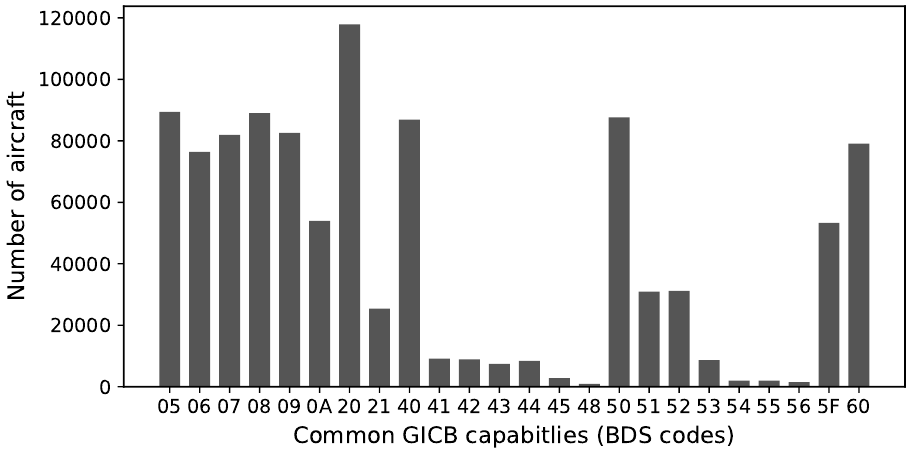
Figure 2. Available GICB capability statistics among all aircraft with valid aircraft typecode information, with a total of around 50,000